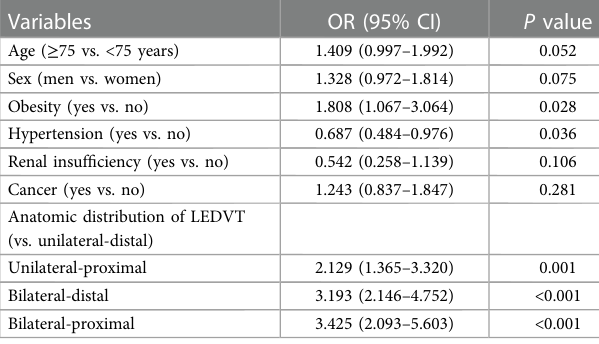
( Supplementary Table S1 , P = 0.053) and sensitivity analysis ( Supplementary Figure S1 , P = 0.113). Also, the literature mentioned above reported no differences in PE incidence between left non-IVT, right IVT and right non-IVT (12.8% vs. 10.1% vs. 16.6%, P = 0.38) (36). Due to a relatively small number